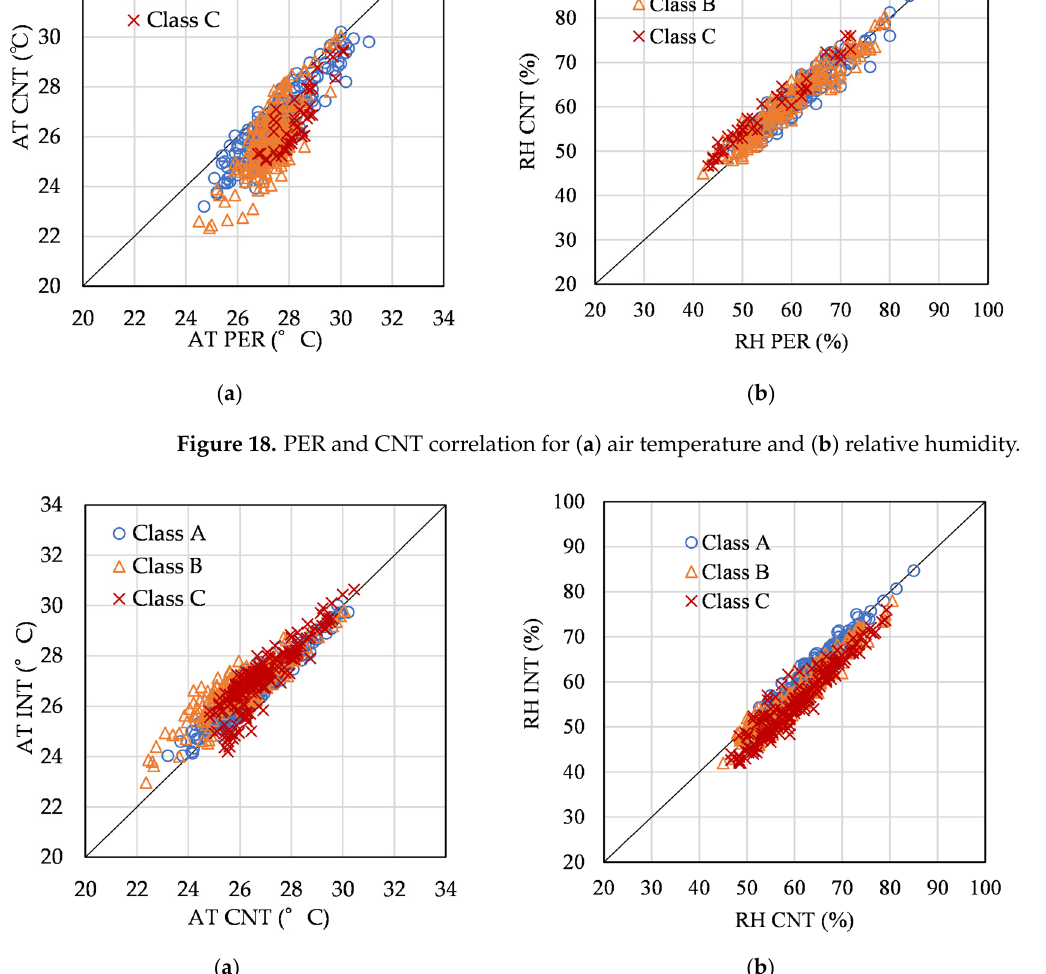
Figure 19. CNT and INT correlation for ( a ) air temperature and ( b ) relative humidity.